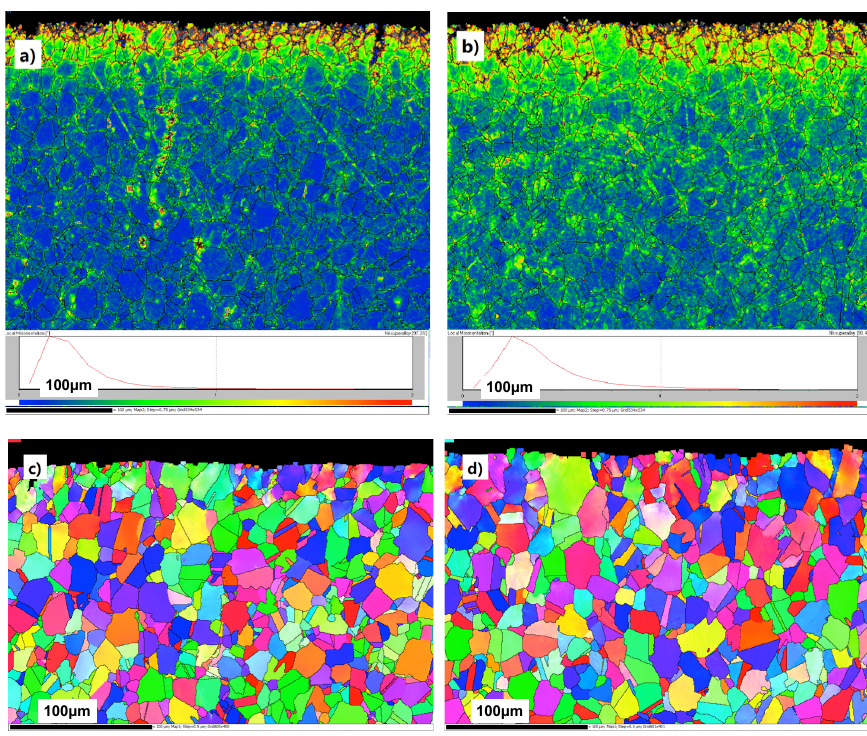
Figure 4. The microstructures of different shot-peened IN718 samples were analyzed by EBSD: ( a ) KAM map of 0.1 mmA, ( b ) KAM map of 0.2 mmA, ( c ) IPF map of 0.1 mmA and ( d ) IPF map of 0.2 mmA. The KAM maps illustrate the distribution of local misorientation in the material and the IPF maps illustrate the grain shape and